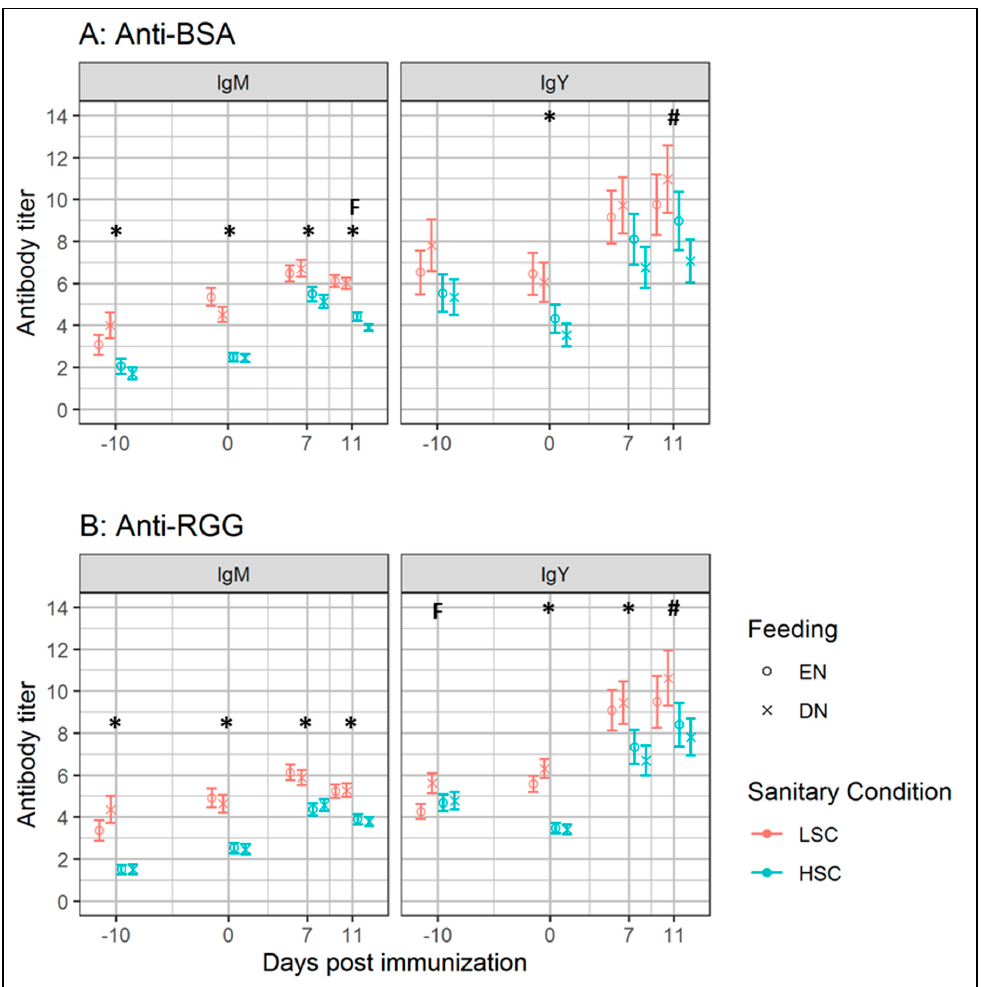
Figure 3. IgM and IgY ‐ binding bovine serum albumin (BSA; panel A ) or rabbit γ‐ globulin (RGG; panel B ) in blood serum of broiler chickens fed with BSA, during the first 3 d of age, receiving delayed (DN) or early nutrition (EN), and kept under either high sanitary conditions (HSC) or under low sanitary conditions (LSC) in experiment II. Broilers were intratracheally immunized with BSA and RGG, at 24 d of age (0 d p.i.). Data are presented as estimated marginal means, with error bars. Within different ages, differences between sanitary condition groups are indicated by * ( p ≤ 0.05) or # ( p ≤ 0.10), and tendencies between feeding groups are indicated by F ( p ≤ 0.10). n = 12 replicate broiler housed in groups of 5 broilers per pen for all groups, except for 7 and 11 d p.i., where n = 10 replicate broilers for all groups, with the exception of DN–HSC ( n = 12 broilers).